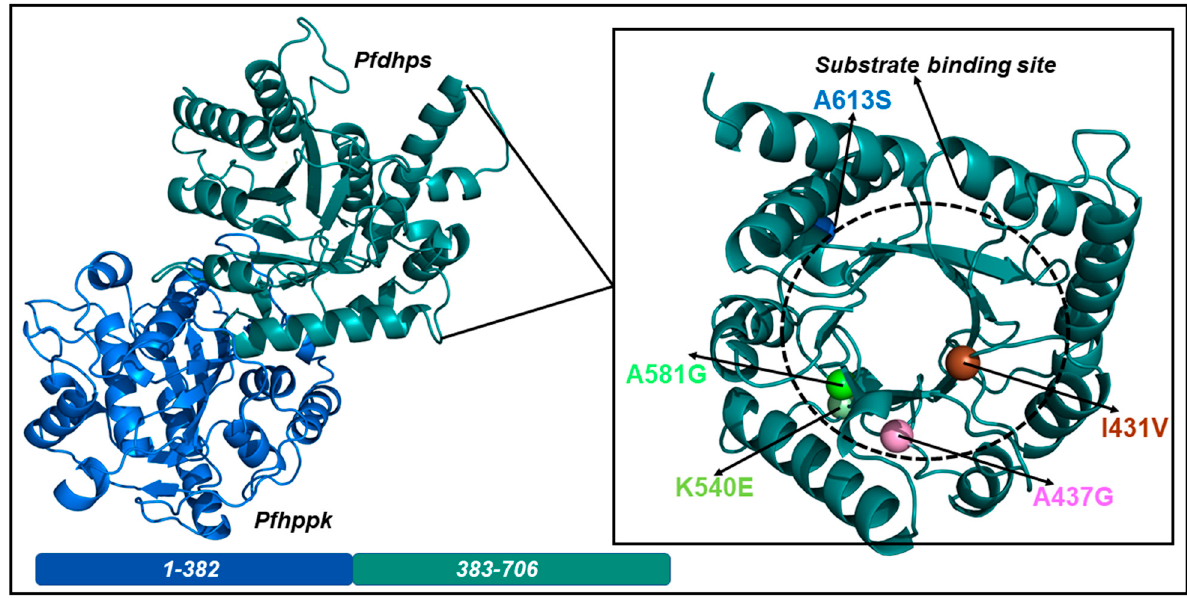
Figure 1. Cartoon representation of the structural components of Pf dhps– Pf hppk. The amino acid ranges for both proteins are indicated in bars, with the Pf dhps segment highlighted in deep teal and the Pf hppk segment in blue. Mutations occurring in Pf dhps are indicated by spheres in the right panel, which is a magnification of the region indicated on the structure to the left. The image was generated using the PyMOL